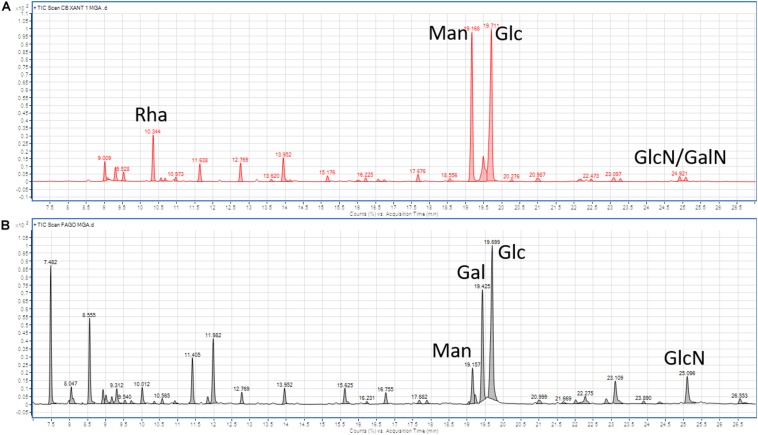
Gas chromatography-mass spectrometry (GC-MS) analysis of (A)
Xcc cells in biofilm, and (B) Xccφ1 particles. Rha, Rhamnose; Man, mannose; Glc, glucose; GalN, galactosamine; GlcN, glucosamine; and Gal, galactose.